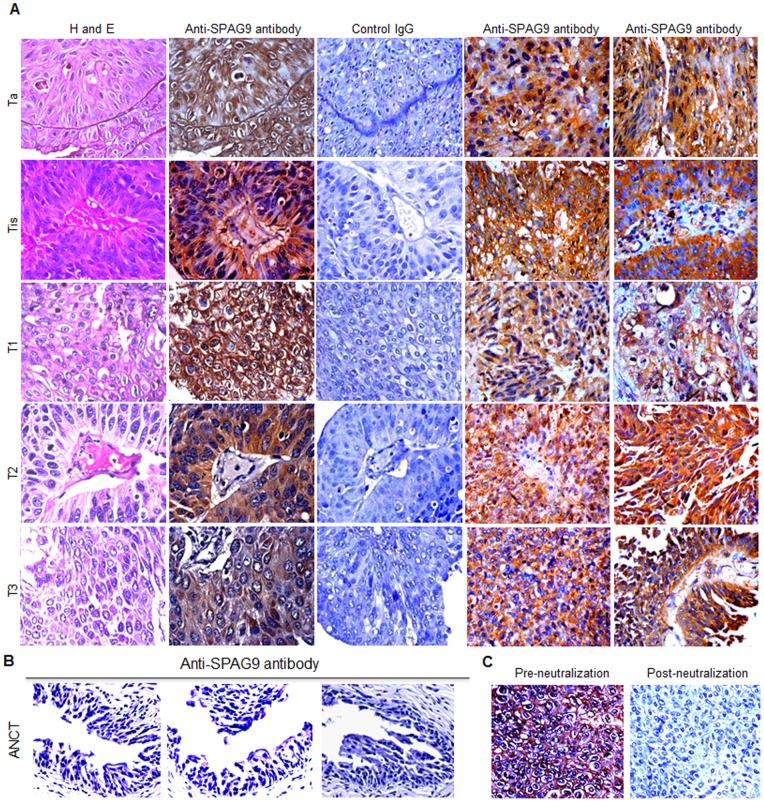
Validation of SPAG9 protein expression in bladder TCC patient’s tissue.(A) Representative H&E stained tissue specimens of Ta, Tis, T1, T2 and T3 stages (I panel). Immunohistochemical analysis of SPAG9 protein expression in matched serial tissue section from the same specimens of Ta, Tis, T1, T2 and T3 stages probed with anti-SPAG9 antibodies showed SPAG9 cytoplasmic localization (II panel). Control IgG showed no reactivity (III panel). Panel IV and V representing different tissue specimens sections of Ta, Tis, T1, T2 and T3 stages probed with anti-SPAG9 antibodies showed SPAG9 protein expression (B) Matched ANCT specimens probed with anti-SPAG9 antibodies showed no reactivity. (C) Representative photomicrographs showing immunoreactivity of anti-SPAG9 antibody before and after neutralization. Neutralization of anti-SPAG9 antibody raised in rats revealed loss of immunoreactivity in IHC which confirms the specificity of anti-SPAG9 antibody. Original magnification, ×400; objective, 40×.